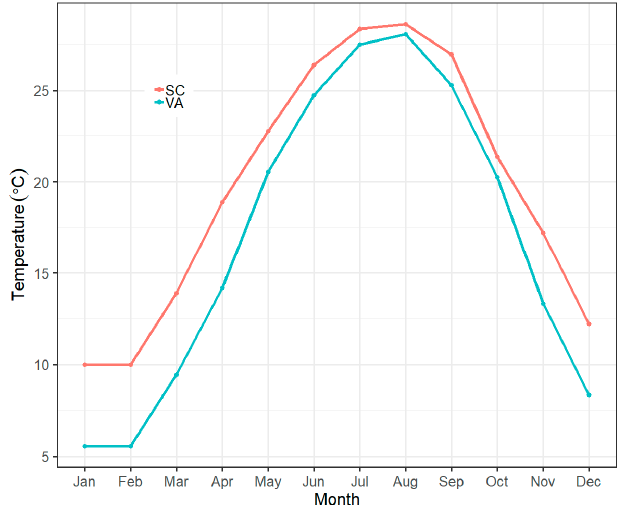
Figure 1. Monthly mean water temperature at two sampling locations. VA = Corrotoman River, Virginia, SC = Charleston, South Carolina.